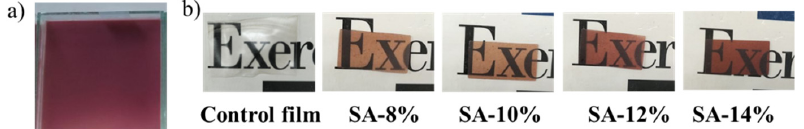
Figure 2. ( a ) The mixture solution cast into plate; ( b ) control film and RCA film physical appearance at four different concentrations. at four different